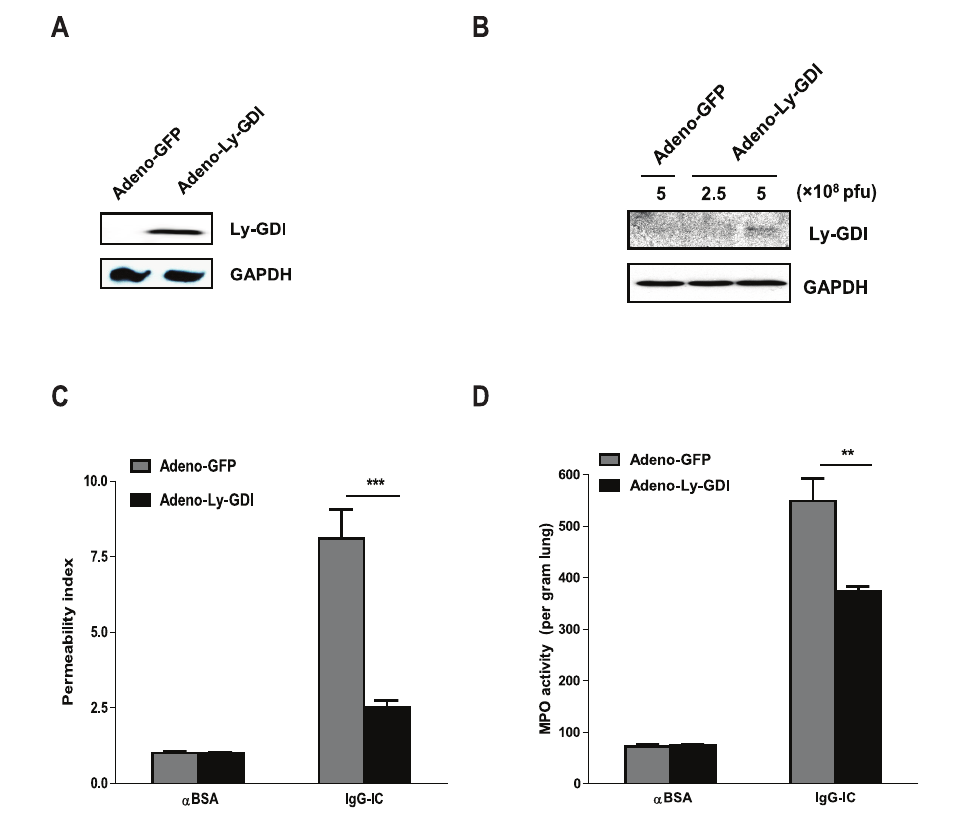
Fig 2. Over-expression of Ly-GDI mitigates IgG immune complex-induced acute lung injury. (A) HEK 293 cells were infected with Adeno-GFP and Adeno-Ly-GDI (with a Flag tag in N-terminal), respectively. When cytopathic effect became evident, the infected cells were lysed by using RIPA buffer. ( B ) Mice received intratracheal injection of Adeno-GFP or Adeno-Ly-GDI at the indicated doses. 3 days later, whole lung proteins were extracted by using RIPA buffer. Total proteins obtained from adenovirus-infected HEK 293 cells or mouse lungs were subjected to Western blot by using rabbit anti-Flag antibodies. The level of GAPDH was shown at the bottom as a loading control. ( C and D) Adeno-GFP or Adeno-Ly-GDI was injected to mice via an airway instillation at a dose of 5 × 10 8 PFU. 3 days later, the mice were subjected to IgG immune complex-induced lung injury or control treatment ( α BSA only). Mouse albumin levels (C) in BAL fluids were measured 4 h later, and the permeability index was expressed as the ratio of the albumin in the IgG immune complex-injured lungs versus that in the control-treated lungs of same type of mice. Lung MPO activity (D) was evaluated, and used as a marker for pulmonary neutrophil accumulation. Data were expressed as means ± S. E. M. N (cid:1) 3 mice for each group. ** and *** indicated statistically significant difference- p < 0.01 and p < 0.001,